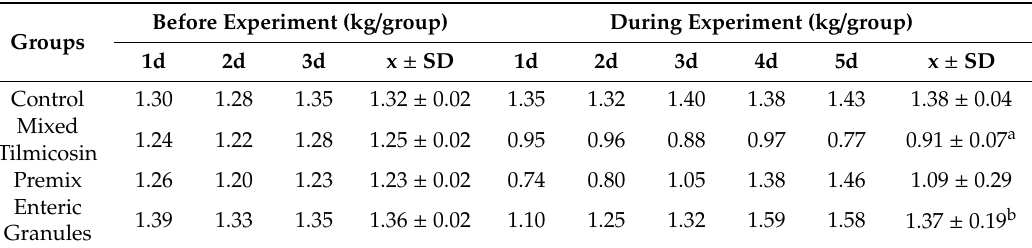
Table 5. The daily feed intake of pigs (Mean ± SD, n = 3).